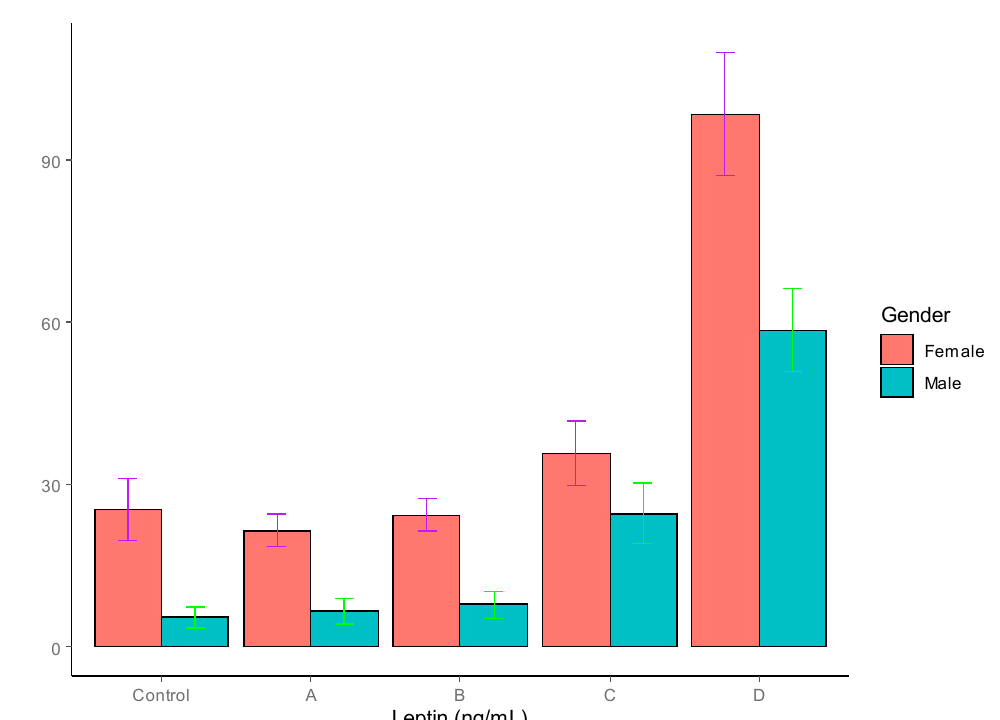
Figure 2. Serum leptin levels in T2DM patients and control groups (ng/mL).